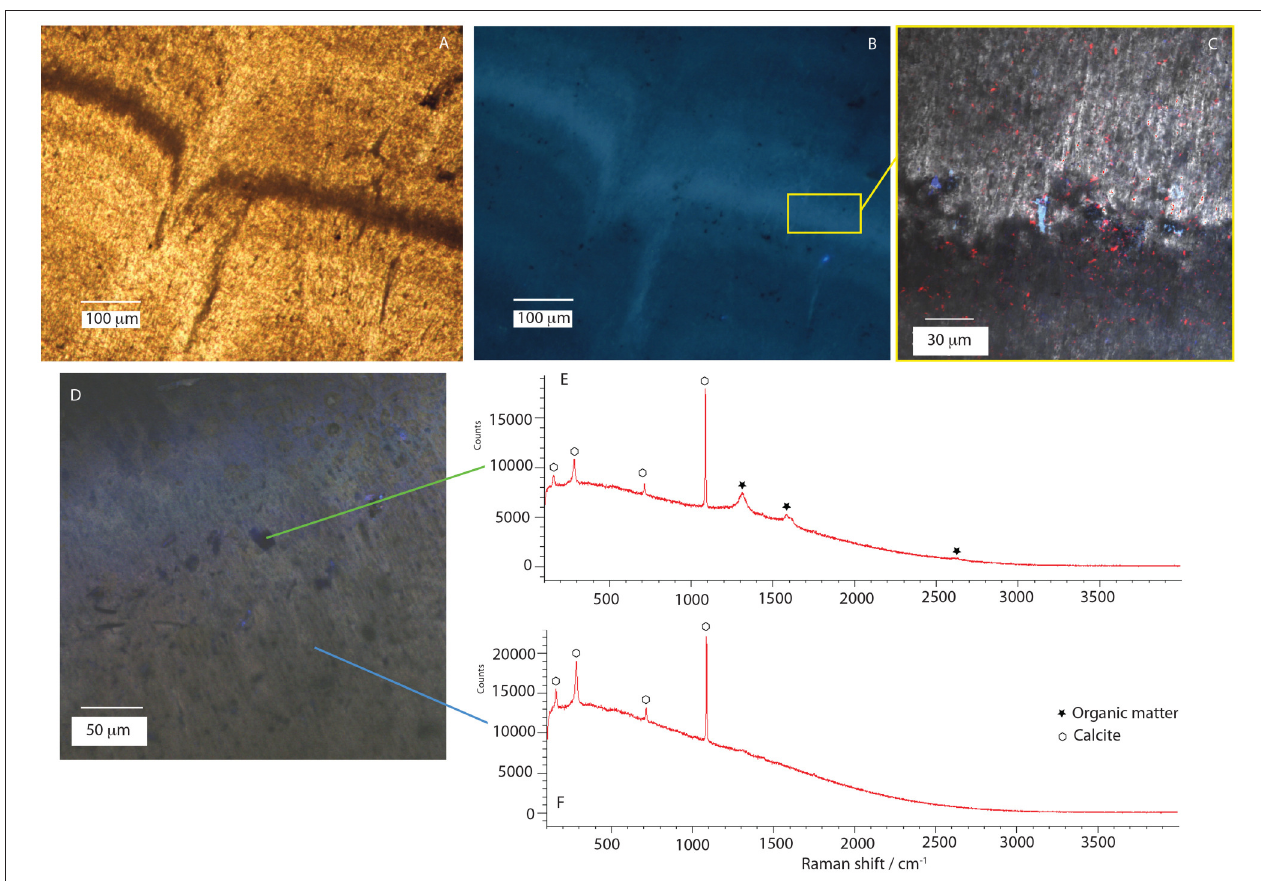
FIGURE 9 | Results of epifluorescence and Raman confocal microscopy. (A) transmitted light and (B) UV excited epifluorescence microscopy images of sample STB1. (C) confocal laser scanning microscopy image of sample STB 1; blue and red colors illustrate area of UV reflection. (D) confocal laser scanning microscopy image of sample BOS2-2 with associated Raman spectrum acquired in dark globule (E) and surrounding fibrous sparitic calcite (F) .